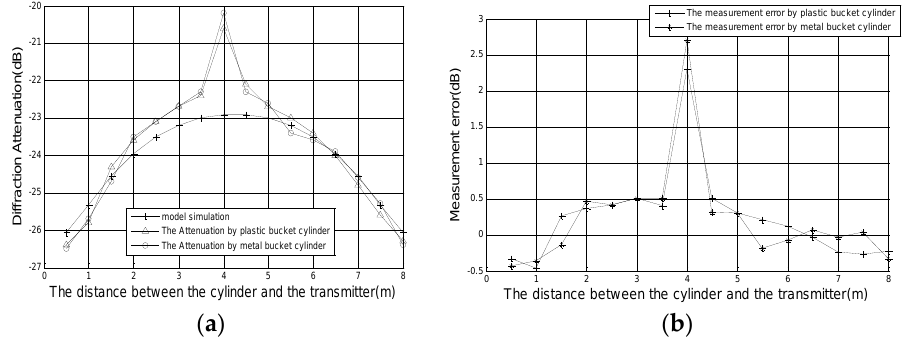
Figure 5. Measurement results and error curves under two cylinder blocks of different materials: ( a ) Measurement results and theoretical simulation curves under one cylinder block; ( b ) Error analysis of two cylinder blocks measurement results.